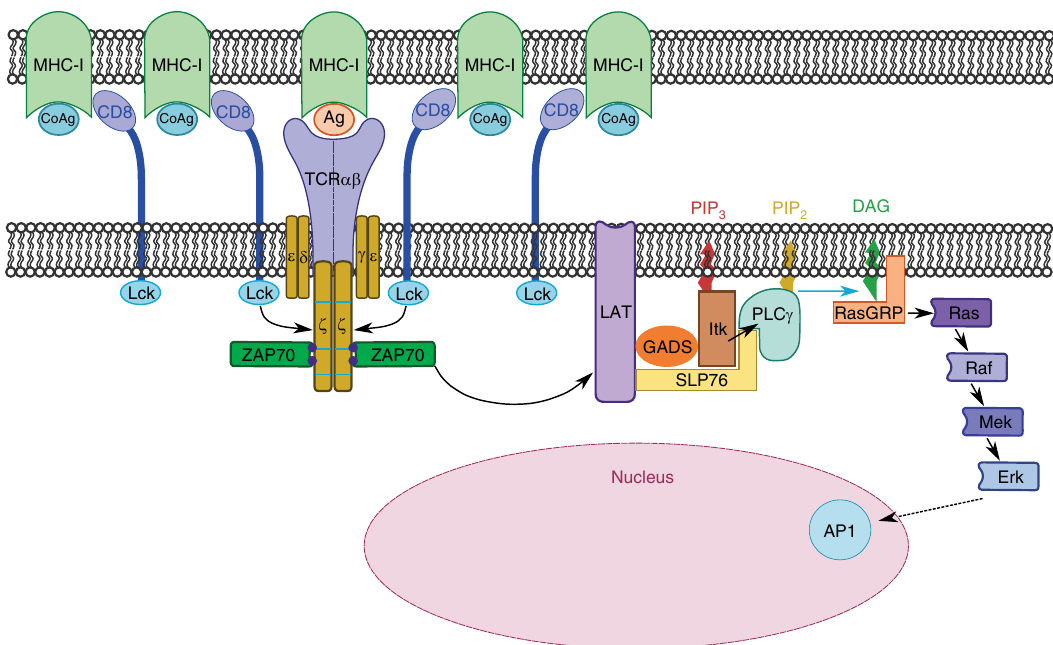
Fig. 9 Analog ampli fi er model for the mechanism of coagonism. Nonstimulatory pMHC molecules recruit CD8-Lck into the immunological synapse. Preconcentrated Lck further phosphorylate the ITAMs of TCR-CD3 ζ which are engaged with speci fi c antigenic pMHC. Enhanced pCD3 ζ provide more docking sites for Zap70 to be phosphorylated. Enhanced pZap70 signal ampli fi es the downstream TCR signaling pathway including the phosphorylation of Erk. pErk translocates into the nucleus and enhances the effector functional readouts of T-cell